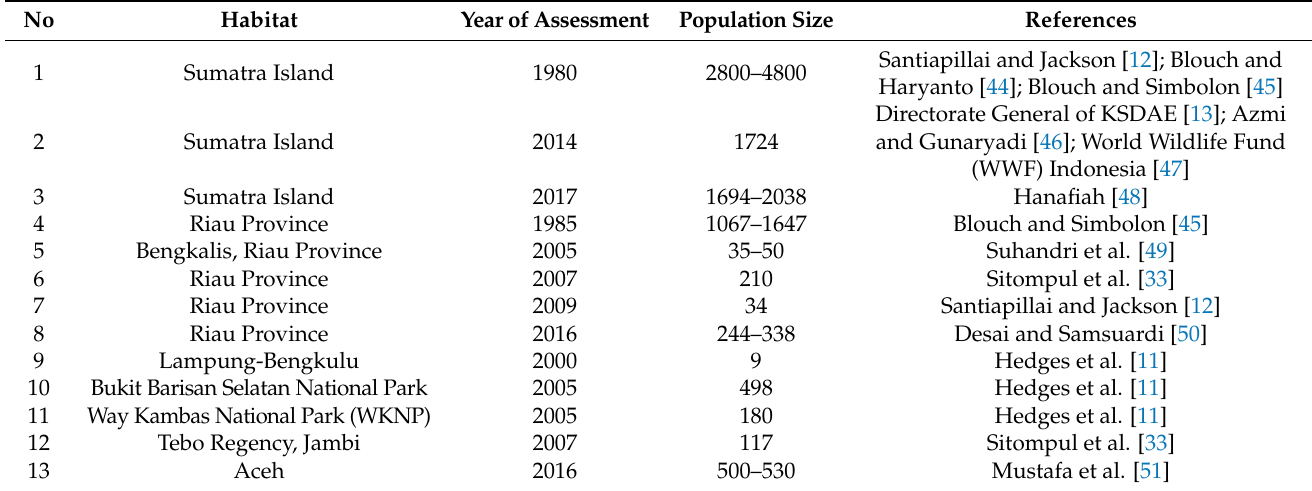
Table 1. Estimation of elephant populations on Sumatra Island.